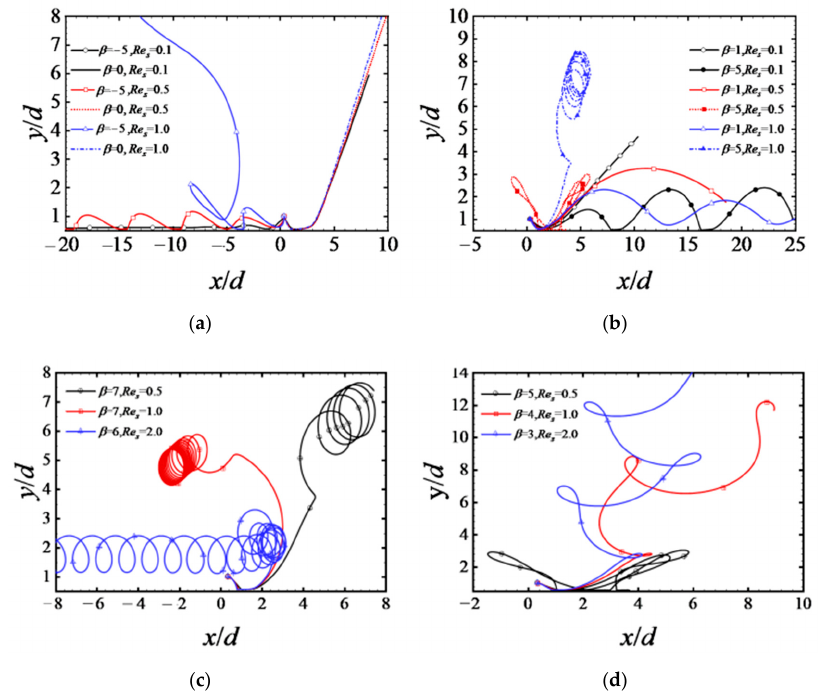
Figure 7. Trajectory of rod-shaped squirmers at different values of Re s ( s = d , i = 2): ( a ) β = − 5, β = 0; ( b ) β = 1, β = 5; ( c ) a circular motion; ( d ) motion trajectories of two transition states, i.e., octagonal motion, and the motion away from the wall accompanied by alternating clockwise and anticlockwise transformation.